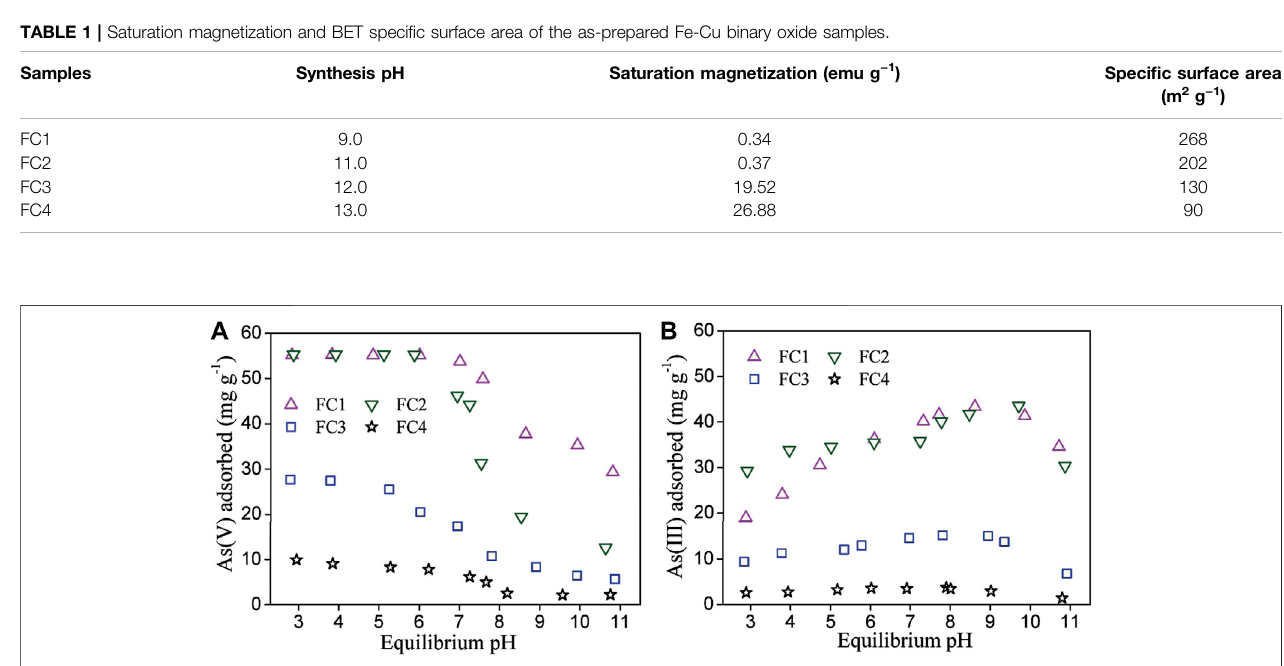
FIGURE4| EffectofsolutionpHon (A) As(V)and (B) As(III)sorptionbyFe-Cubinaryoxides.Initialarsenicconcentration (cid:2) 11.0 mg/L,adsorbentdose (cid:2) 200 mg/L and T (cid:2) 25 ± 1 ° C.